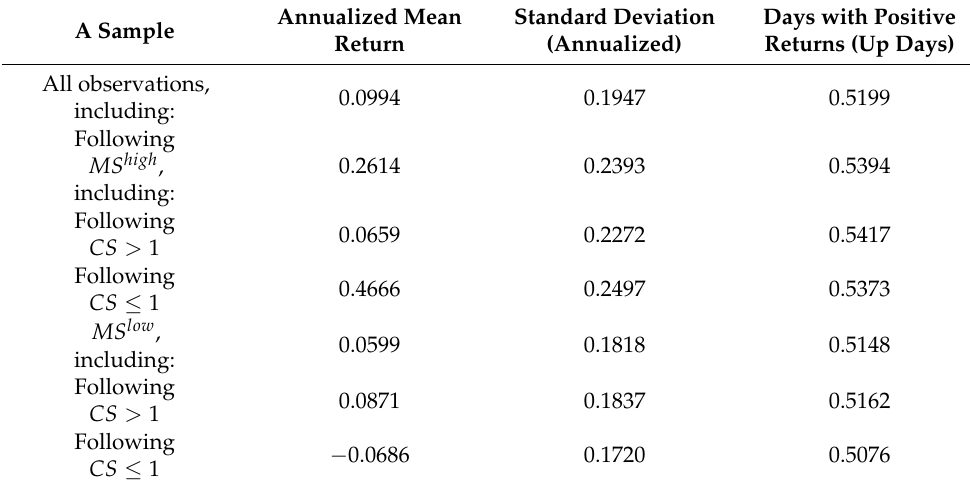
Table 6. Daily asset returns distribution for the RTSI index. A